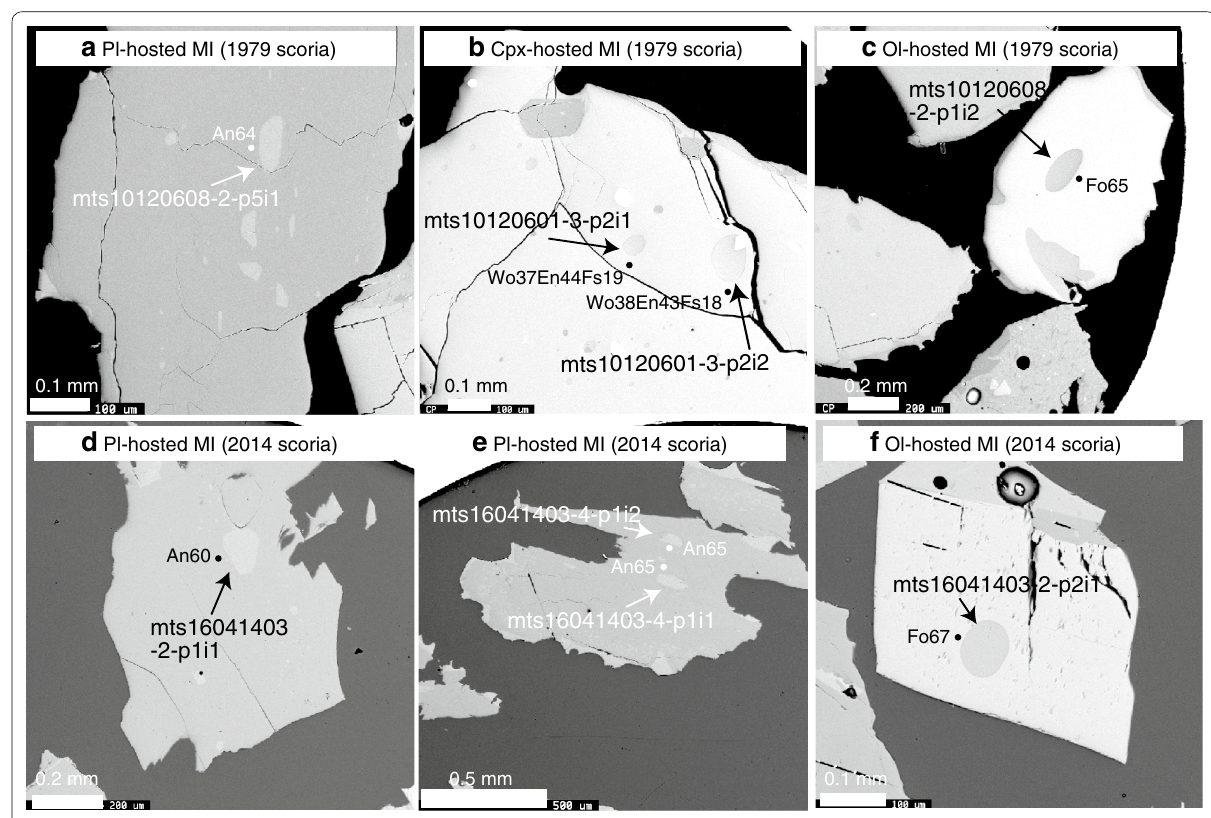
Fig. 4 Backscattered electron images of the melt inclusions contained in the 1979 and 2014 scoria. a A plagioclase-hosted melt inclusion in the 1979 scoria (mts10120608-2-p5i1). b Clinopyroxene-hosted melt inclusions in the 1979 scoria (mts10120601-3-p2i1 and p2i2). c An olivine-hosted melt inclusion in the 1979 scoria (mts10120608-2-p1i2). d A plagioclase-hosted melt inclusion in the 2014 scoria (mts16041403-2-p1i1). e Plagioclase-hosted melt inclusions in the 2014 scoria (mts16041403-4-p1i1 and p1i2). f An olivine-hosted melt inclusion in the 2014